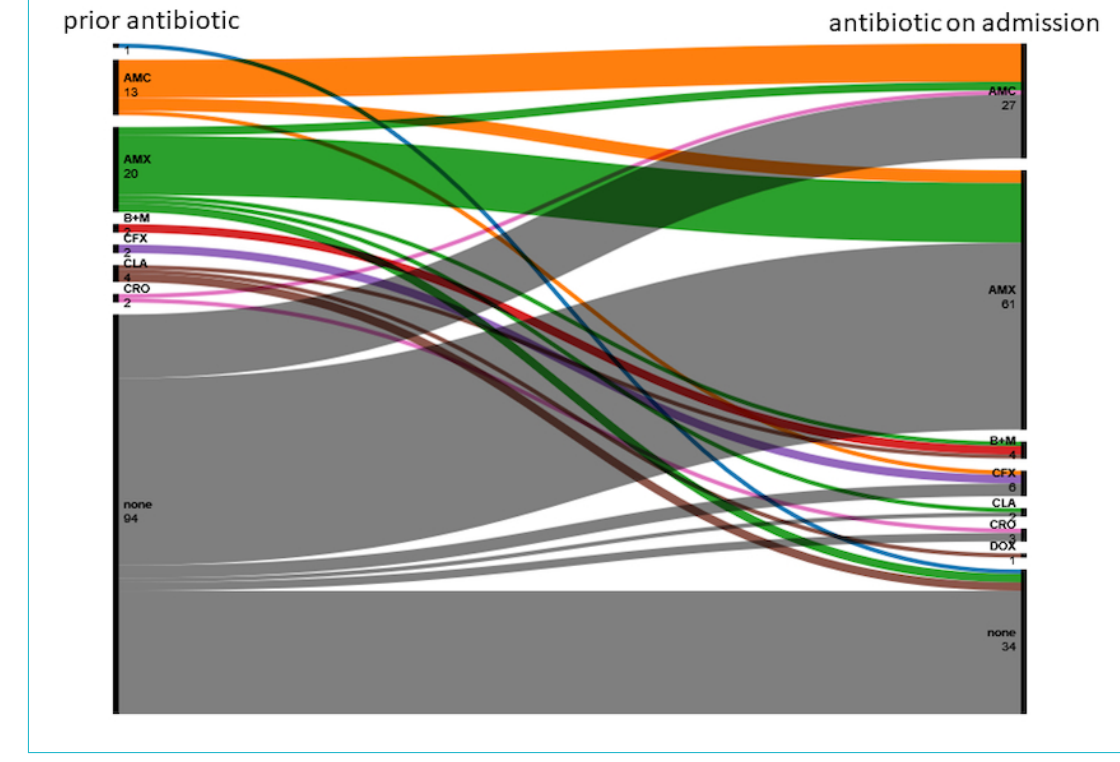
Figure 1: Alluvial plot of antibiotic treatment prior to admission and on admission. No label: unknown; AMC: amoxicillin + clavulanic acid; AMX: amoxicillin; BL + M: beta-lactam + macrolide; CFX: cefuroxime; CLA: clarithromycin; CRO: ceftriaxone; DOX: doxycycline